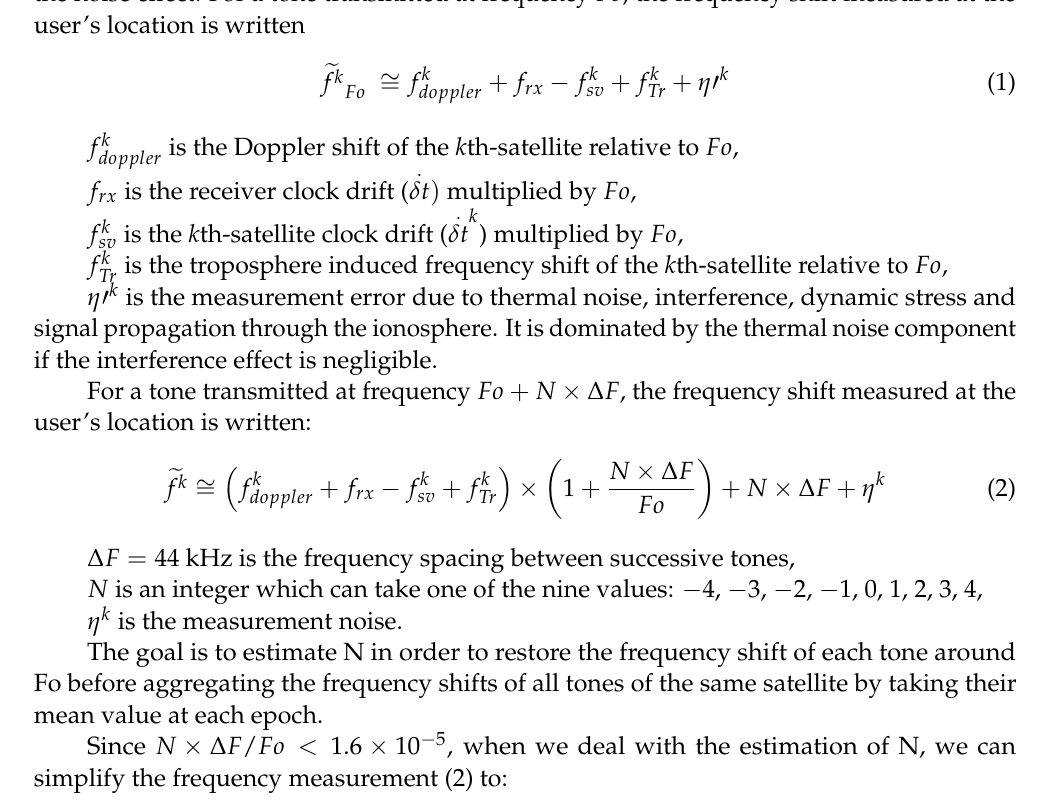
Figure 9. Probability density function of the frequency error of the tones.